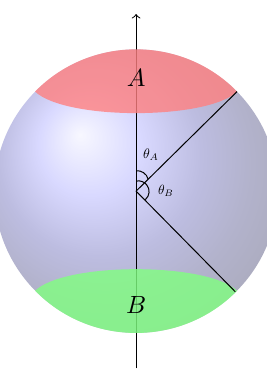
Figure 11 . Two polar cap regions A and B centered around antipodal points of S 2 .